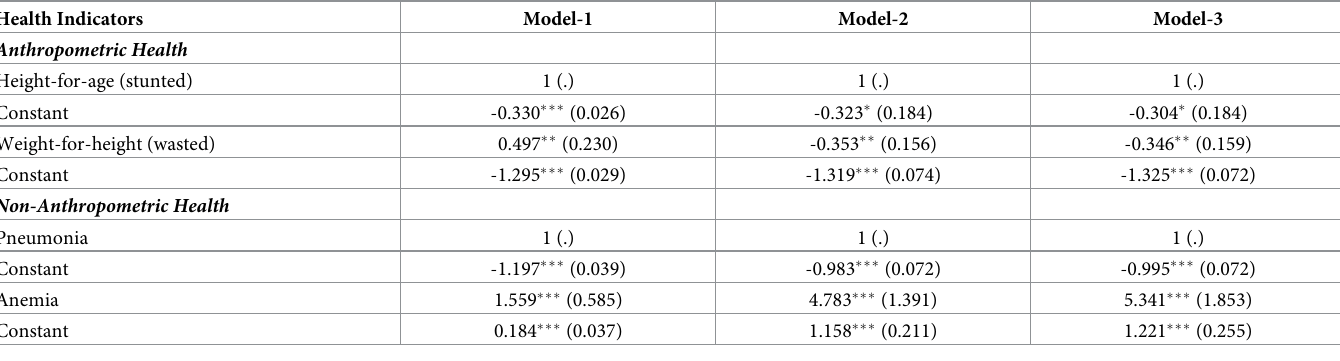
Table 2. Regression results of the measurement part of the MIMIC